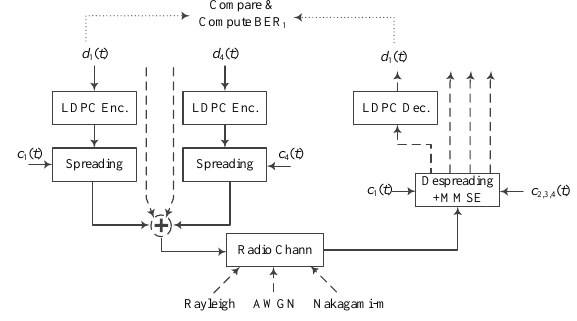
Figure 1 – Tested LDPC-SS multiuser system